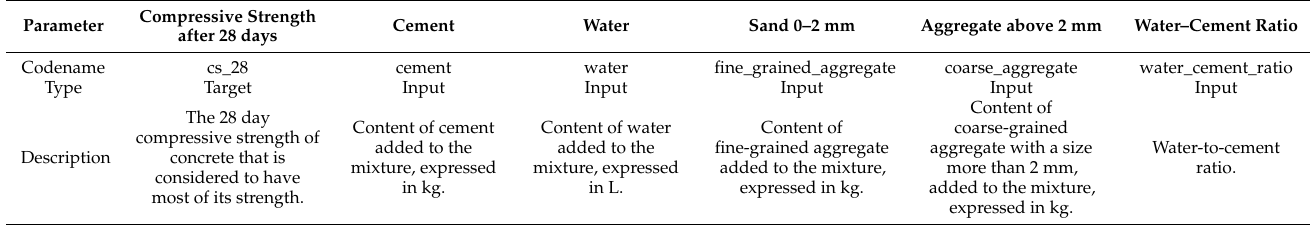
Table 1. The parameters adopted in the